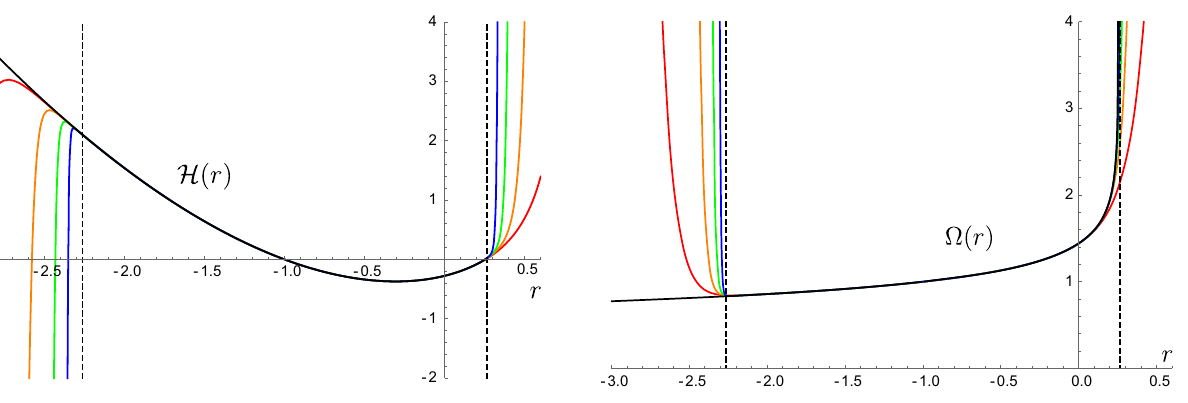
Fig. 3 Series (41) and (42) for the metric functions H ( r ) (left) and (cid:10)( r ) (right) for the first 20 (red), 50 (orange), 100 (green), and 200 (blue) terms for values (cid:9) = 0, (cid:2) = 0, r h = − 1, k = 1 / 2, c 0 = − 1, a 0 = 1, b = 1 / 5. Similarly as in Fig. 1, the coefficients a i and c i seem